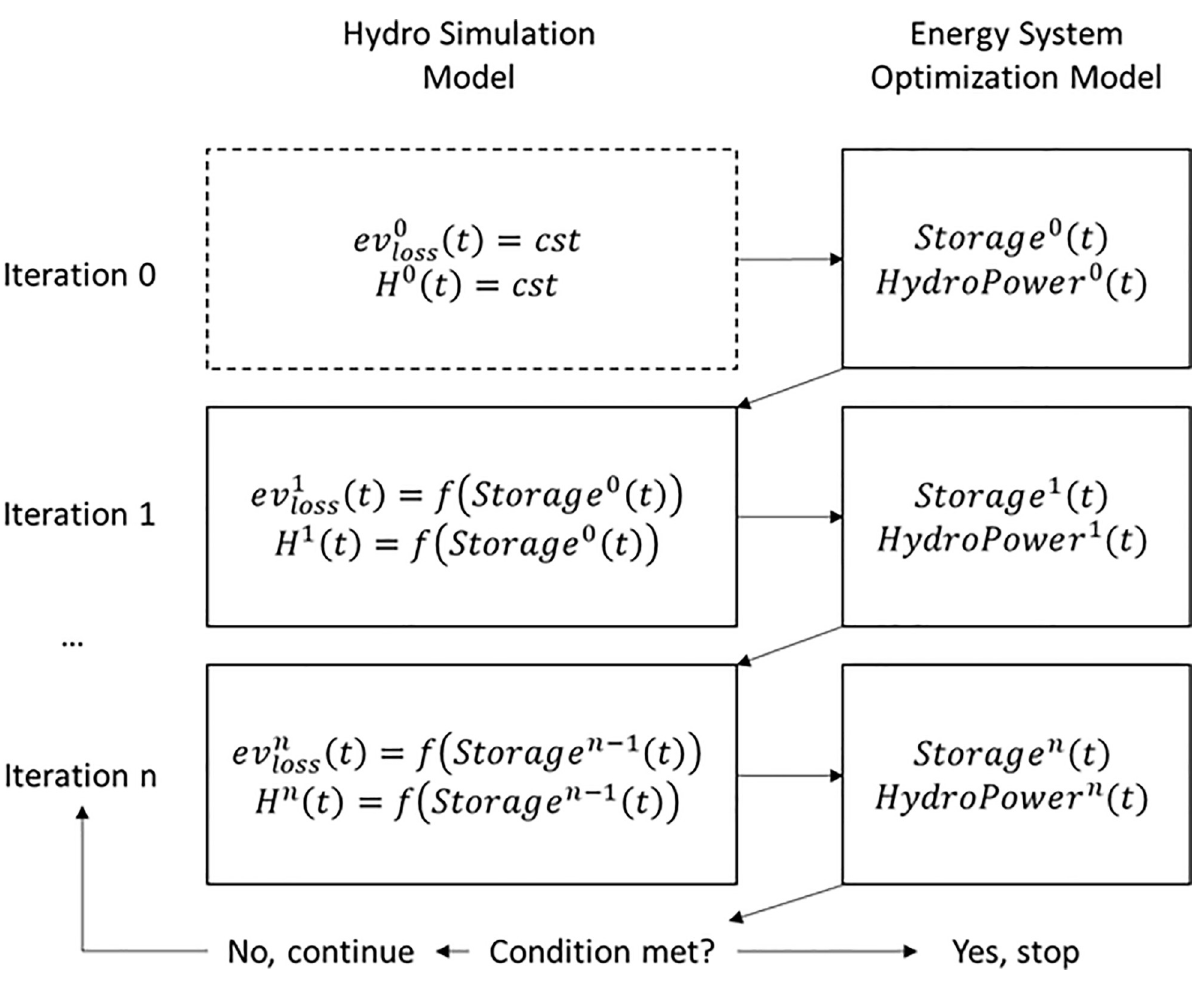
Fig 3. Logical scheme of iteration between the two